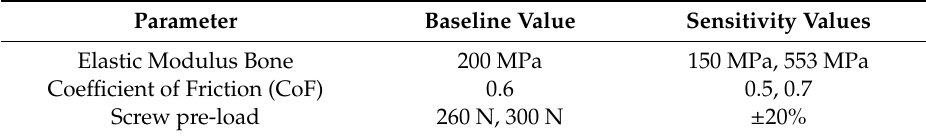
Table 1. Parameter variation for the sensitivity